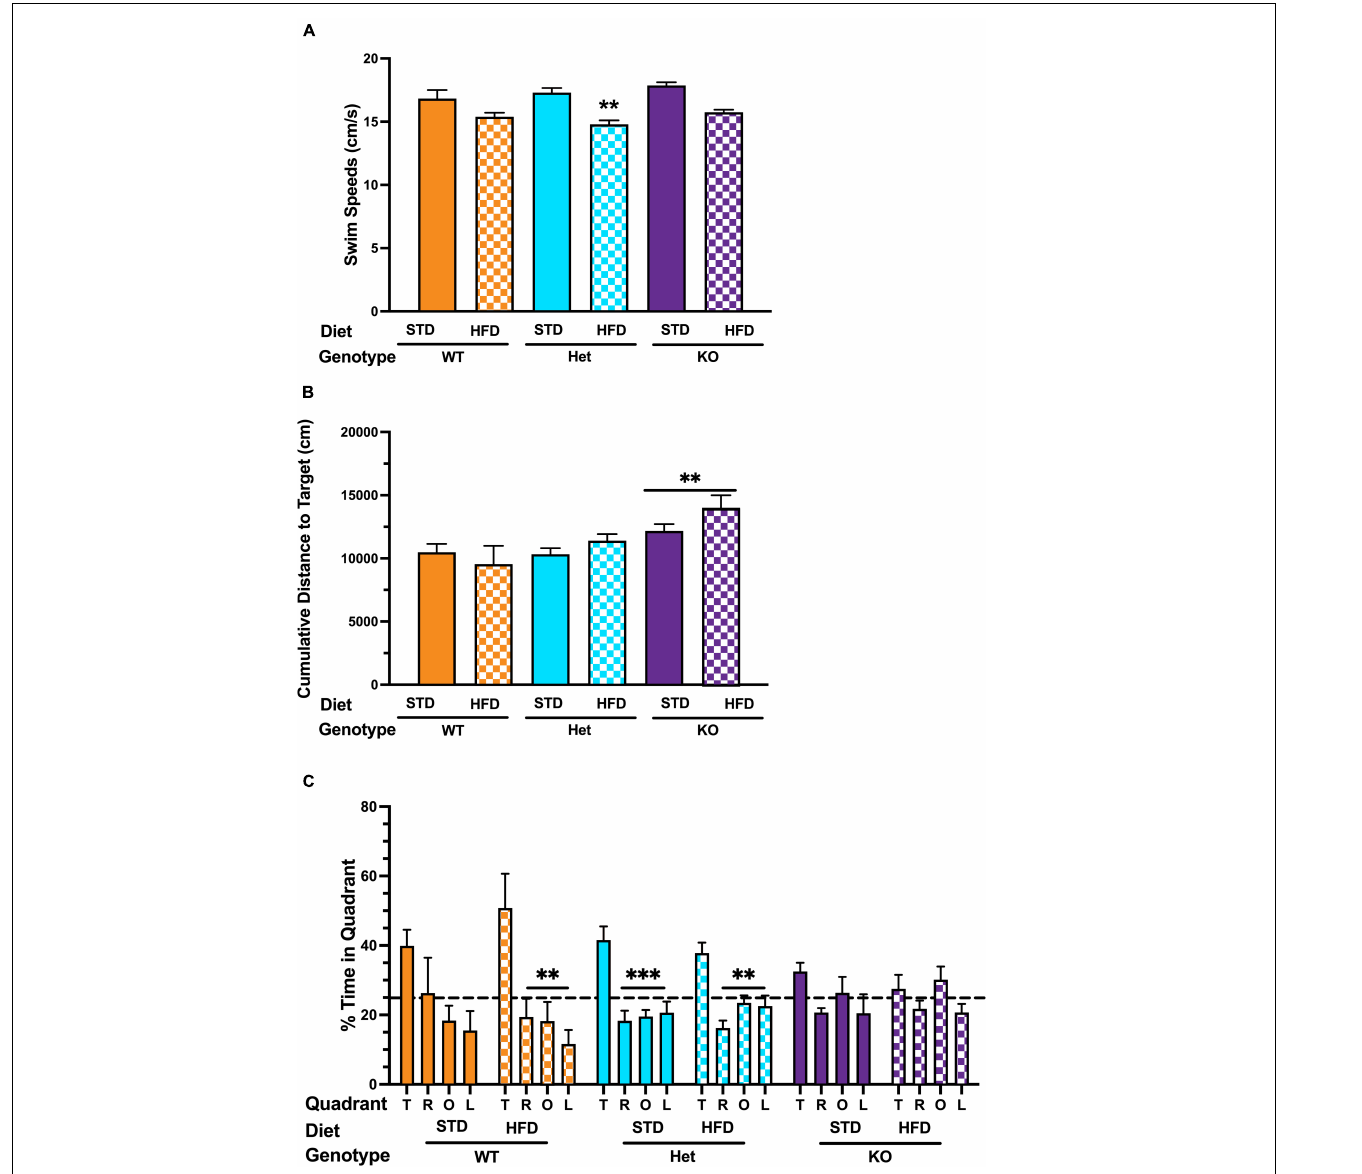
FIGURE 2 | Effects of GPR39 deficiency on memory retention in the water maze. (A) Swim speeds during the visible platform showed an effect of diet in Het mice, with lower swim speeds in Het mice fed with HFD. (B) There was no effect of diet on latency or cumulative distance to the target in any genotype during visible or hidden platform training. However, KO mice fed with HFD took longer to locate the platform than KO mice fed with STD. (C) Spatial memory retention in the water maze probe trial showed an effect of quadrant in WT mice on a STD. However, they did not spend more time in the target quadrant than any non-target quadrant. WT on HFD spent more time in the target quadrant than any other quadrant. Het mice on a STD and HFD also spent more time in the target quadrant than any other quadrant. In contrast, no effect of quadrant was seen in KO mice on STD or HFD. All values represent means ± standard error of the mean, ∗∗ p < 0.001, ∗∗∗ p < 0.0001, n = 5–10 per